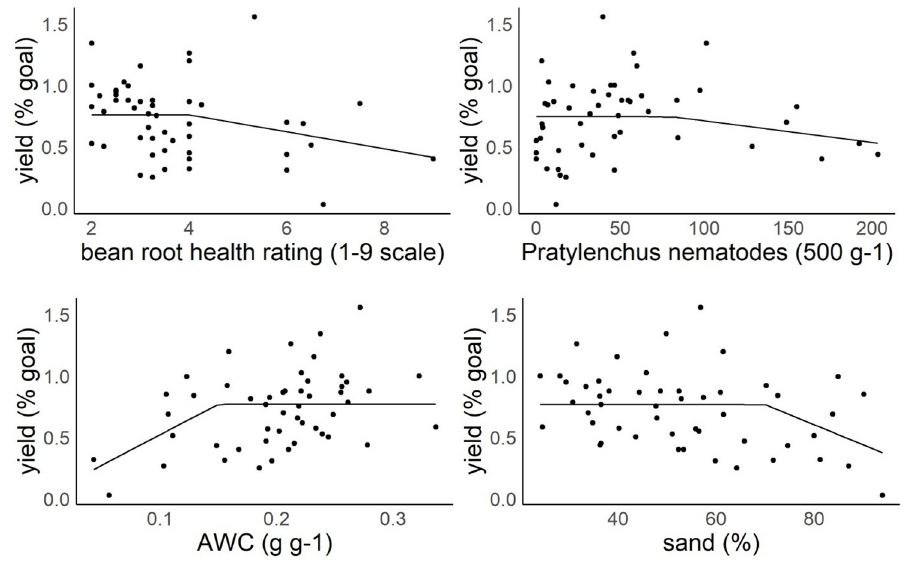
Fig 8. Linear mixed effects model Pratylenchus nematodes (500 g -1 ), bean root health rating (1–9 scale), AWC (g g -1 ), sand (%) and yield (% goal). AWC = available water capacity.